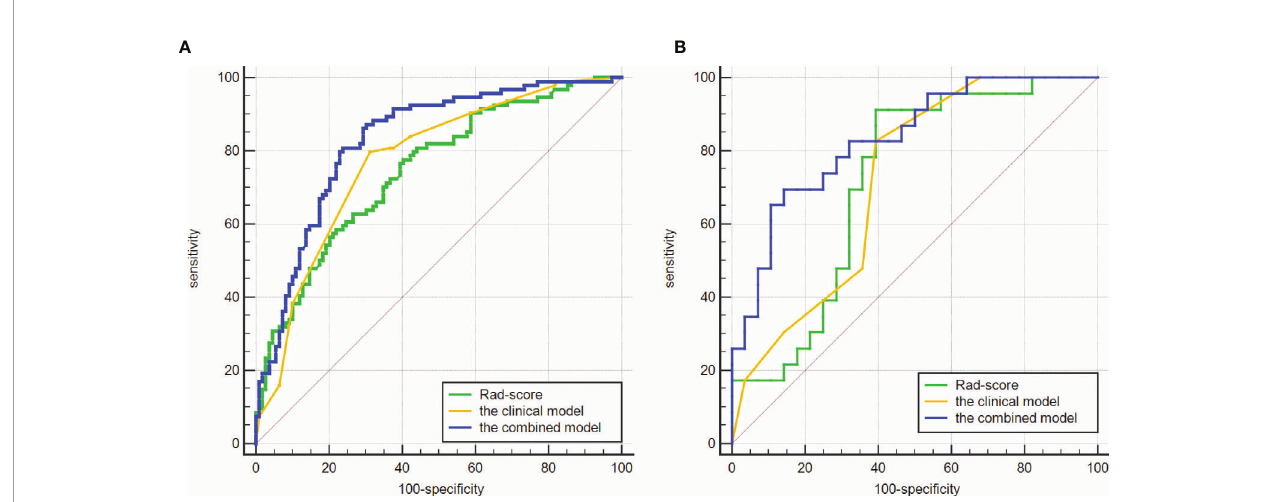
FIGURE 5 | Comparisons of ROC curves. (A) in the training cohort. (B) in the validation cohort. The combined models had higher AUCs (0.830 and 0.832) than the clinical model (0.773 and 0.718).